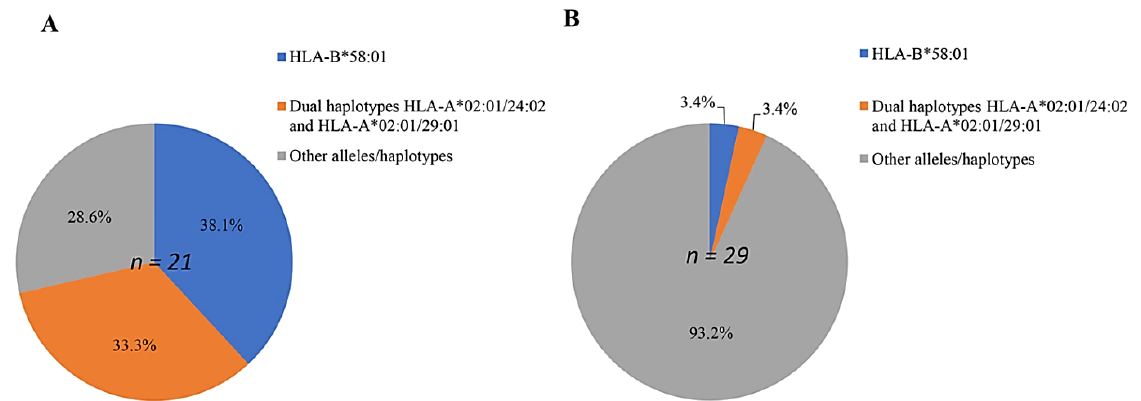
Figure 1. Percentage of predominant single alleles and dual haplotypes distributed in patients with ALP-induced MCARs ( n = 21) ( A ), and in ALP-tolerant patients ( n = 29) ( B ).